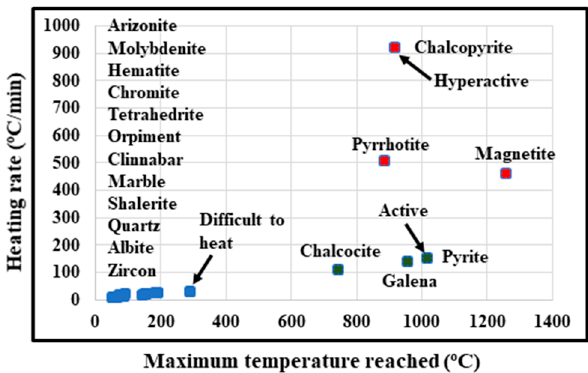
Figure 7. Heating response of minerals in a microwave (data source: [53]).